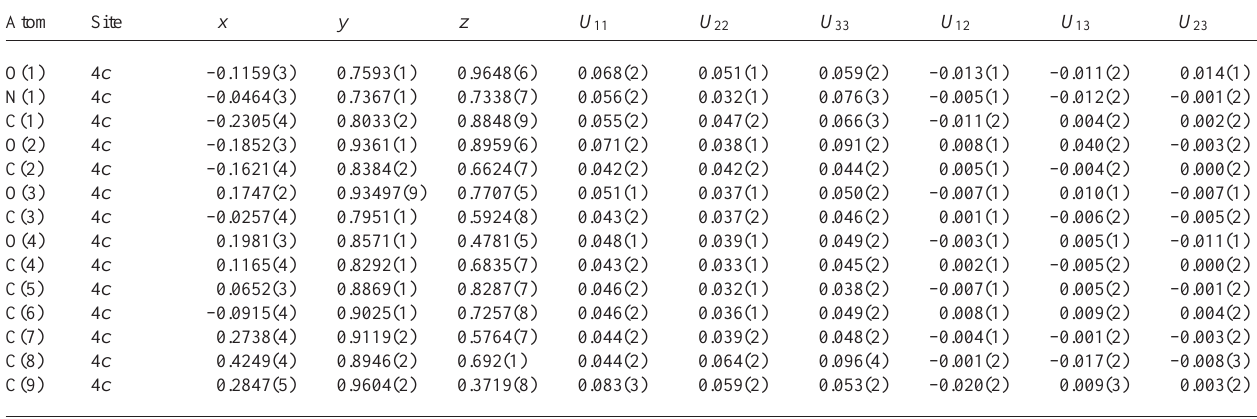
Table 3. Atomic coordinates and displacement parameters (in Å 2 )